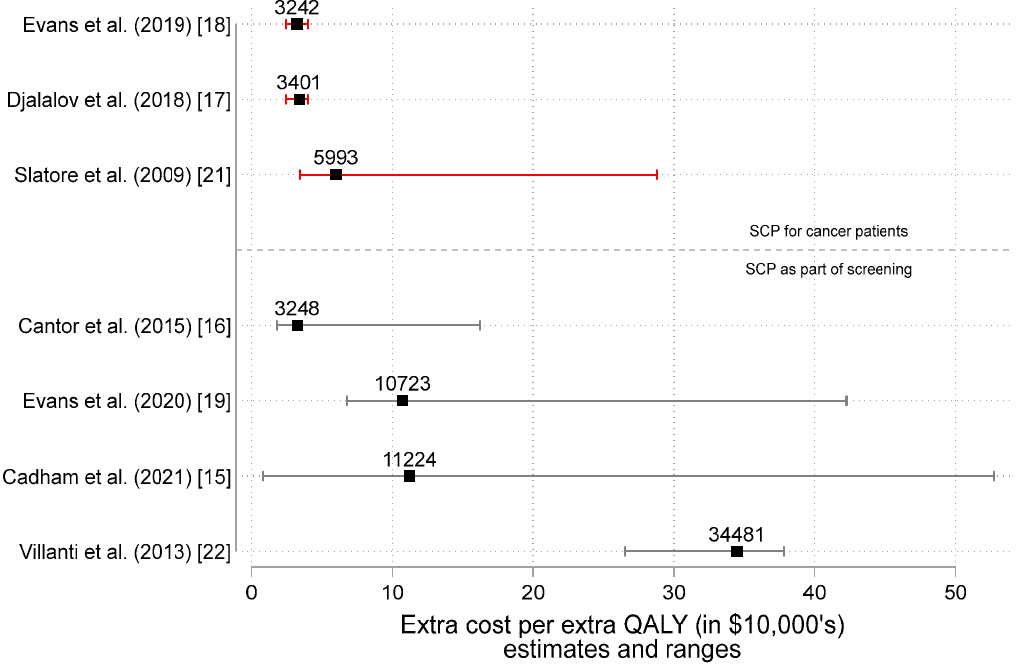
Figure 5. Estimates of the incremental cost-effectiveness ratio (ICER = Δ C and Δ E estimates) in 2022 Canadian dollars by study type [15–19,21,22]. Note: Figure 5 illustrates the estimates and ranges for the extra cost per extra QALY (in $10,000 ′ s) as reported in the peer-reviewed scientific literature on smoking cessation programs (SCPs). The ratio Δ C/ Δ E (i.e., the incremental cost-effectiveness ratio or ICER) is shown as the label for each point. Results from studies of SCPs for cancer patients appear above while study results for SCPs supplementing cancer screening programs appear below. Miss- ing from the studies of SCPs as part of screening are the results from Goffin et al. (2016) [20]. Inter- ested readers are directed to Table 2 in the Goffin et al paper for 14 different estimates conveying that SCPs are more effective and more costly). 4. Discussion 4.1. Integrating Methods with Published Work: Effectiveness , Cost and Cost-Effectiveness 4.1.1. Effectiveness The results from our general modeling exercise demonstrated that gaining “nothing” from SCPs occurs if either Δ E 1 or Δ E 2 is zero. These scenarios happen when the couplet ( Δ E 1 , Δ E 2 ) is located on the vertical or horizontal axis of Figure 2 (or Figure 3). For example, if 25% of people in a smoking cessation program (SCP) quit but there is no benefit from quitting (i.e., Δ E 1 = 0.25 and Δ E 2 = 0.0), then there is no expected gain (since Δ E 1 × Δ E 2 = 0). Another example occurs in Figure 2, where there is an “X” at the point (0, 0.1). This corre- sponds to a SCP having zero chance of improving quit rates paired a 10% chance that patients who quit will have better outcomes. This point in Figure 2 is labeled 0 since there is no expected gain from a SCP. However, once one assumes that there is at least some gain both in terms of (1) less smoking and (2) some benefit from less smoking, the expected value is positive and having a SCP is more effective than not. Based on our literature search we found evidence suggesting that it is likely neither Δ E 1 nor Δ E 2 is zero. For example, for Δ E 1 , there is recent evidence from a cost-effectiveness of implementing smoking cessation interventions for patients with cancer [14]. Levy et al. (2022) used data from the Smokefree Support Study (conducted 2013–2018; completed 2021), to estimate quit rates between 21.4% and 34.5% with a SCP. The quit rate of 14.3% for “usual care” came from Park et al. [25]. These estimates are congruent with a low Δ E 1 estimate of 7.1% (i.e., 21.4–14.3) or high estimate of 20.2% (i.e., 34.5–14.3). For SCP